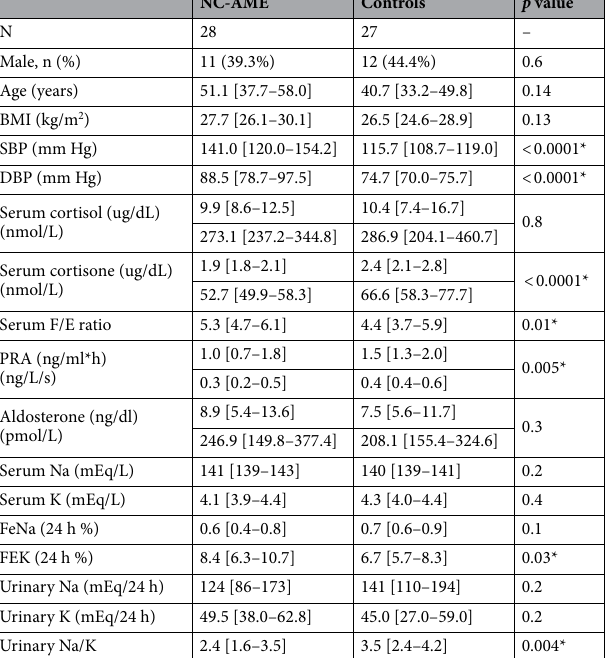
Table 1. Clinical and biochemical characteristics of the studied subjects. Values correspond to median [Q1– Q3]. BMI body mass index, SBP systolic blood pressure, DBP diastolic blood pressure, F / E cortisol to